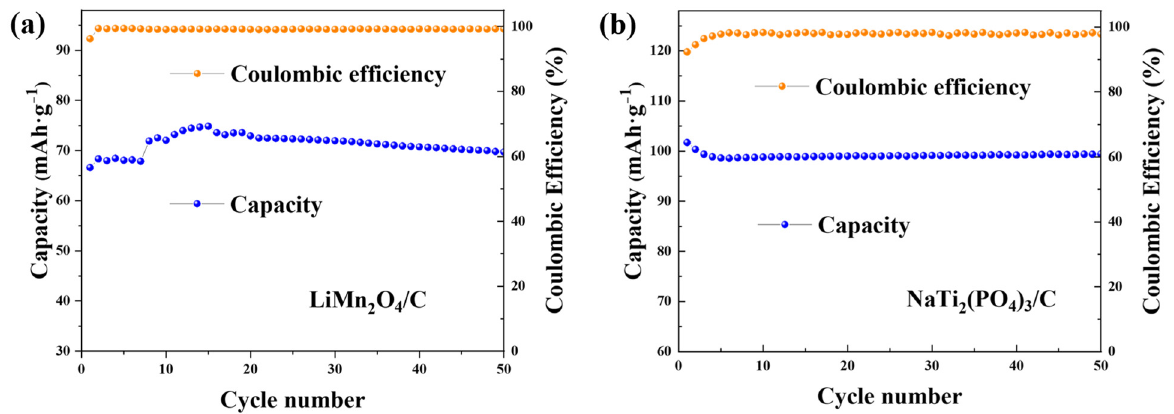
Figure 5. The cycling profiles of ( a ) LiMn 2 O 4 /C in 1.0 M LiCl solution and ( b ) NaTi 2 (PO 4 ) 3 /C with the constant current density of 0.1 g·A − 1 .